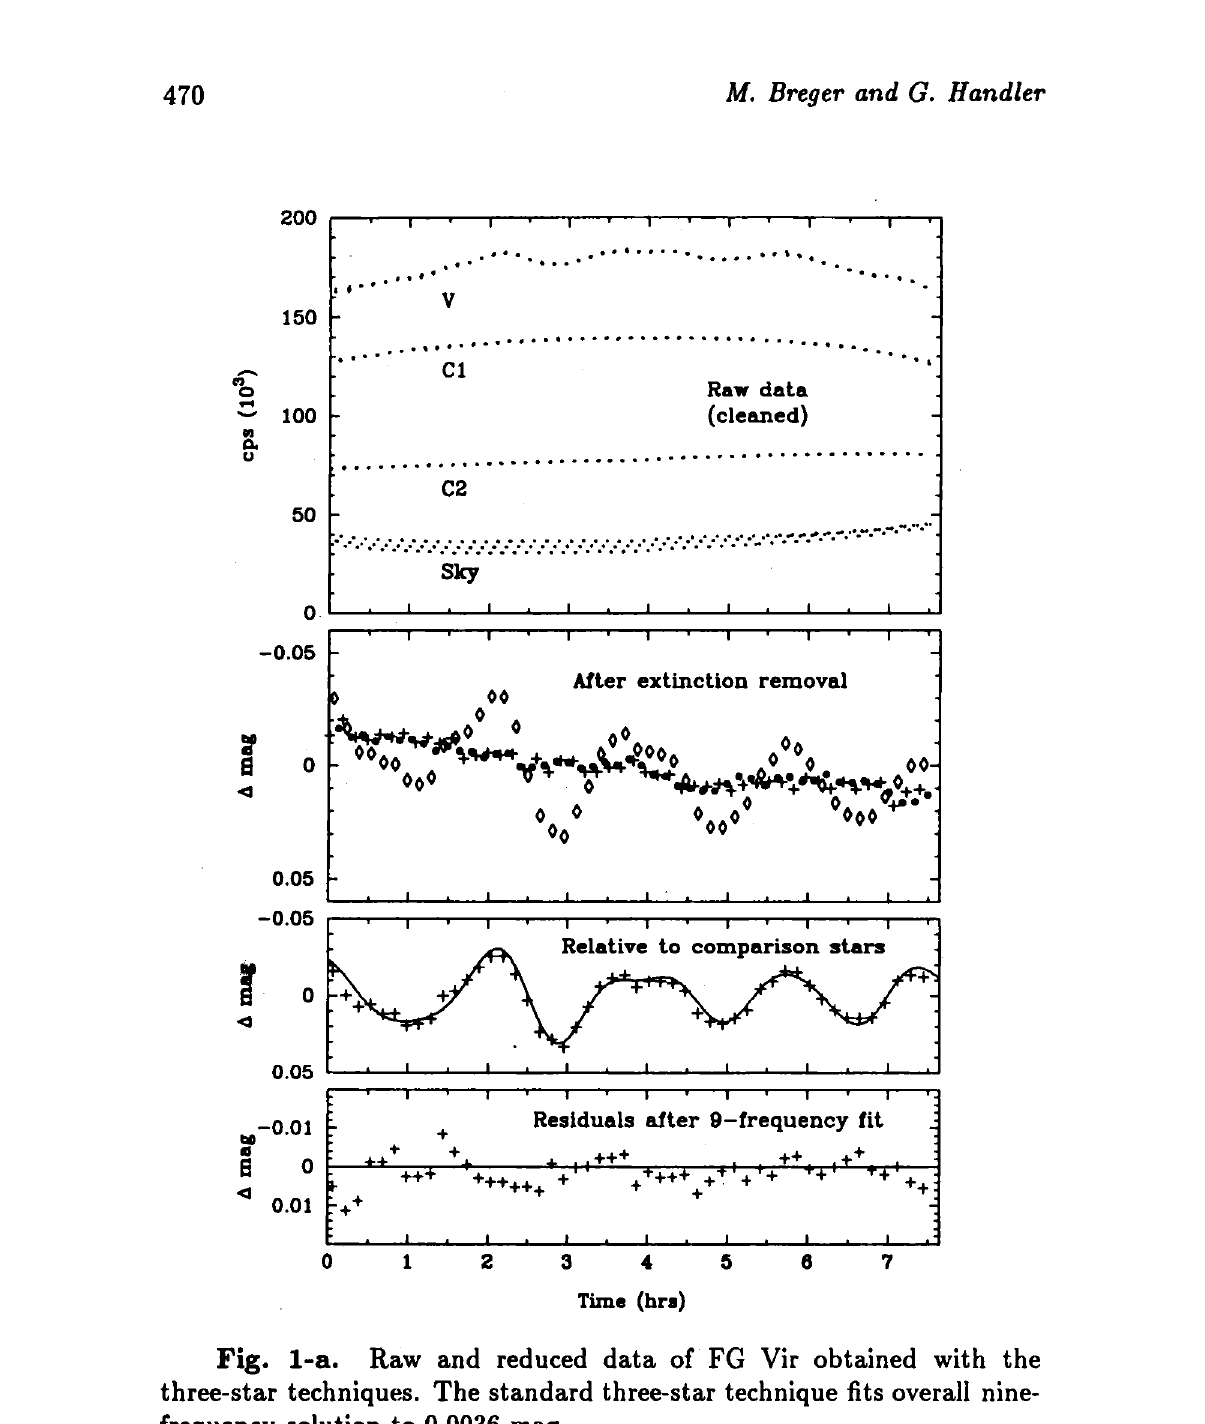
Fig. 1-a. Raw and reduced data of FG Vir obtained with the three-star techniques. The standard three-star technique fits overall nine- frequency solution to 0.0036